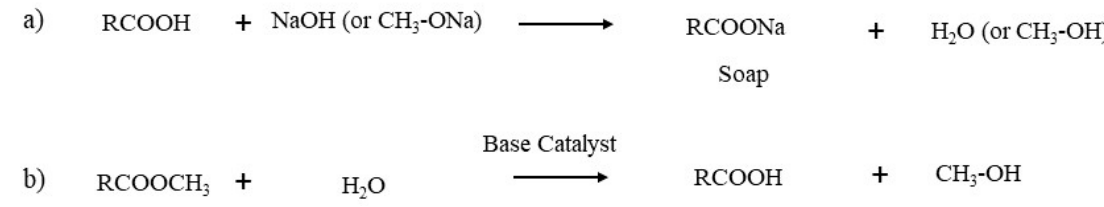
Figure 3. Transesterification reactions of glycerides with methanol.